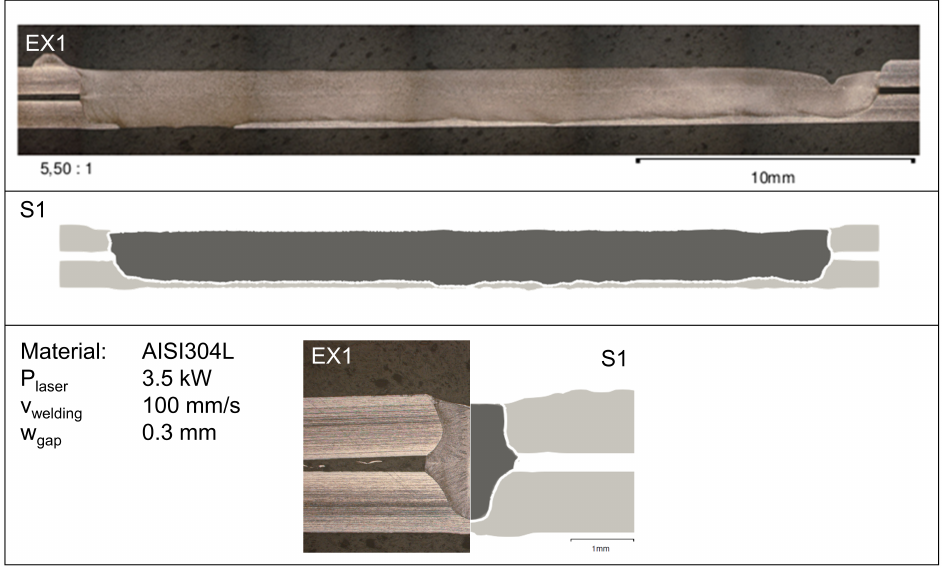
Figure 4. A comparison of experiment EX1 and simulation S1 (model